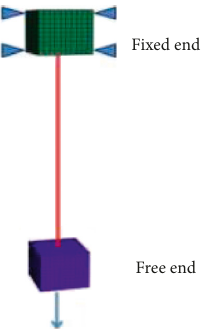
of the monitoring area. ′